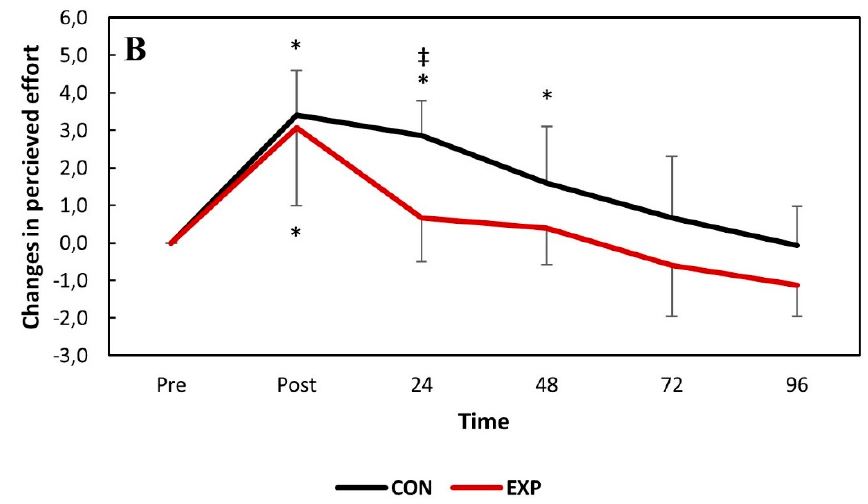
Figure 2. The absolute changes in oxygen uptake ( A ) and perceived effort ( B ) over time following downhill running. * p < 0.05 compared to the baseline values in the same group. ‡ p < 0.05 compared to the experimental group at the same time-point. CON: control group; EXP: experimental group. The isometric peak torque significantly decreased ( p < 0.05) for both groups immediately after DHR and remained so throughout the entire experimental period for the control group, but fully recovered 72 h post-DHR for the experimental group (Figure 3).